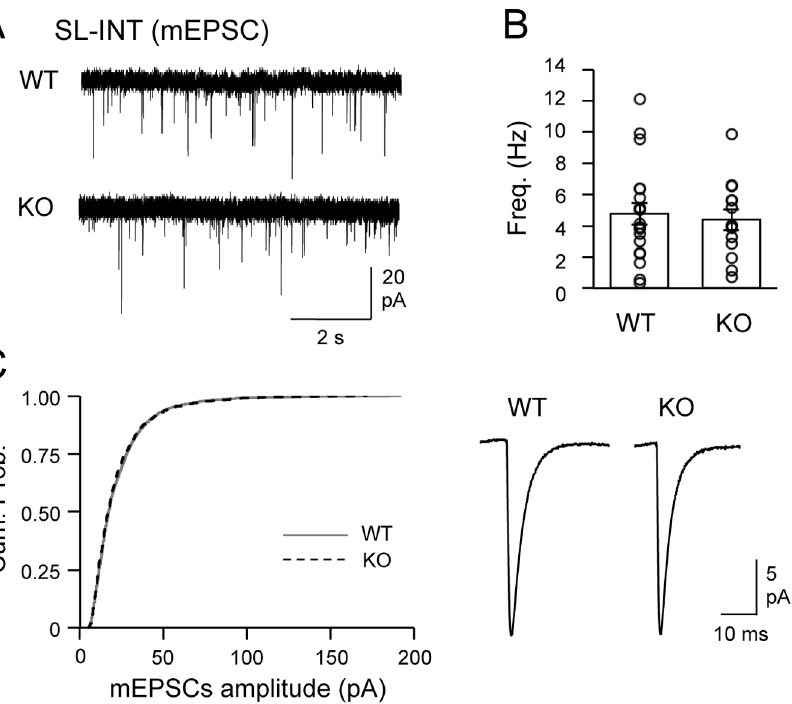
Figure 6. Normal mEPSCs recorded from SL-INTs of BACE1 KOs. (A) Representative mEPSC traces from SL-INTs of WTs and KOs. (B) There was no change in the frequency of mEPSCs from SL-INTs. mEPSC frequency of each cell is shown as open circles. (C) Amplitude of mEPSCs in SL-INTs was not altered in KOs. Left: The cumulative probability curve of KO mEPSC amplitudes (black dotted line) superimposed with that of WT (gray solid line) (K–S test, P=0.2). Right: Average mEPSC traces from SL-INTs of the two groups.